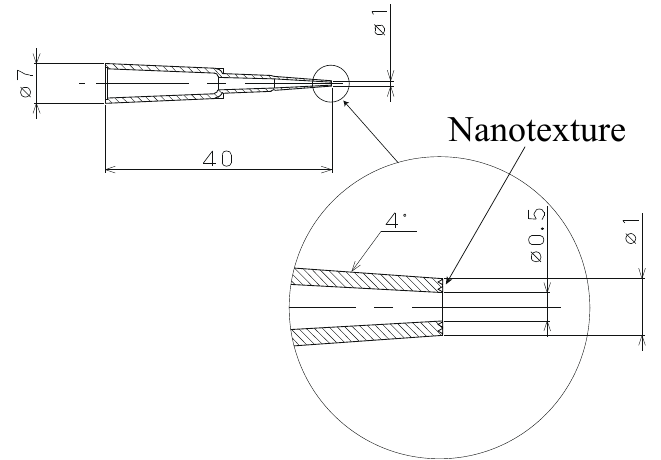
Figure 3. Schematic of the plastic pipette with the nanotexture.